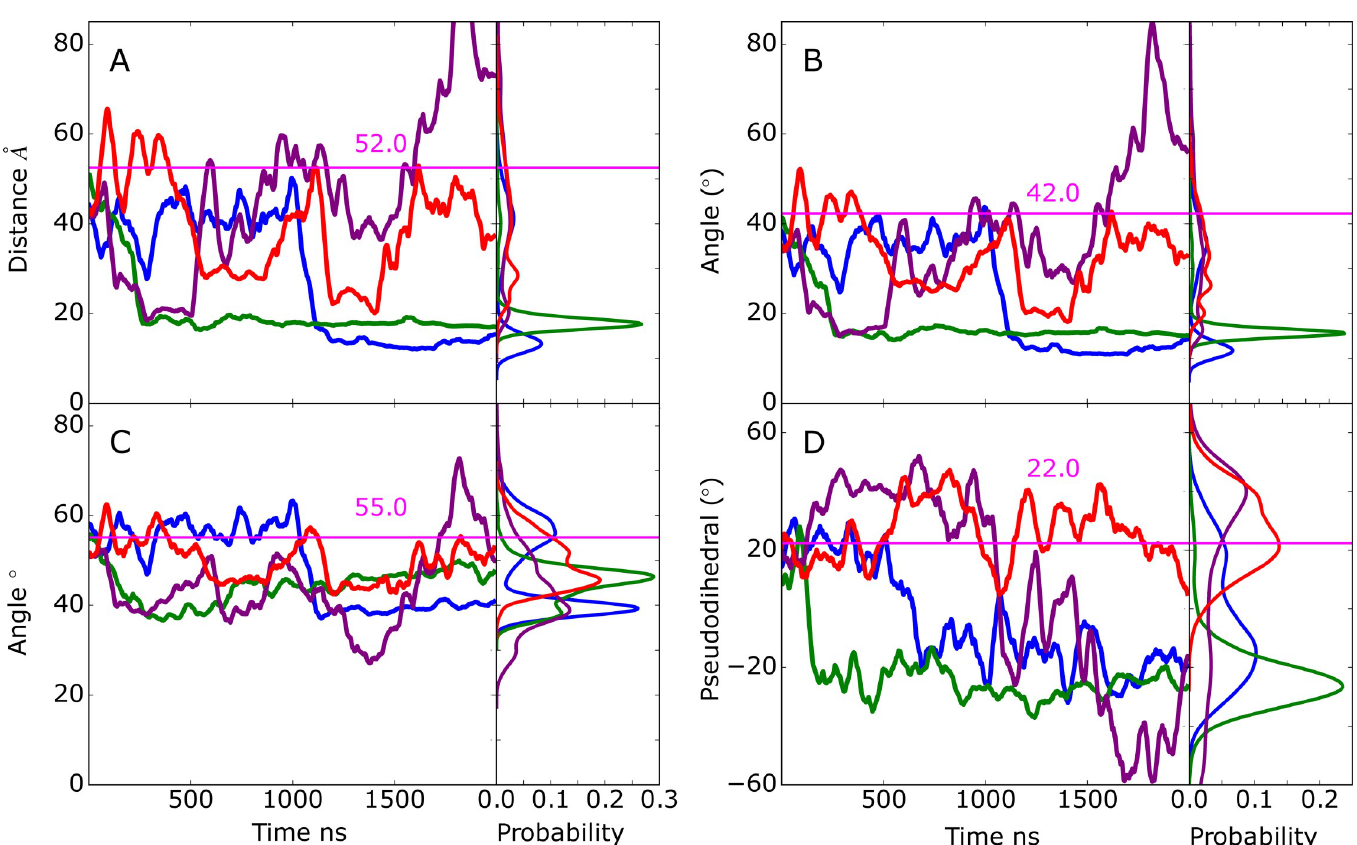
Fig 2. Time series and probability distributions from the apo-EndoS2 MD simulations of the A) distance between the C α atoms of residues 186 and 712, the angles between the C α atoms of residues B) 186-548-712 and C) 186-548-639 and D) the pseudodihedral angle defined by residues 106-508-808-712 as shown in S2A–S2D Fig. Results shown for individual MD simulations 1) blue, 2) green, 3) purple and 4) red. Data is presented as a 50 ns moving average. Values from the EndoS2 crystal structure for the respective terms are shown as horizontal lines along with the measured values in